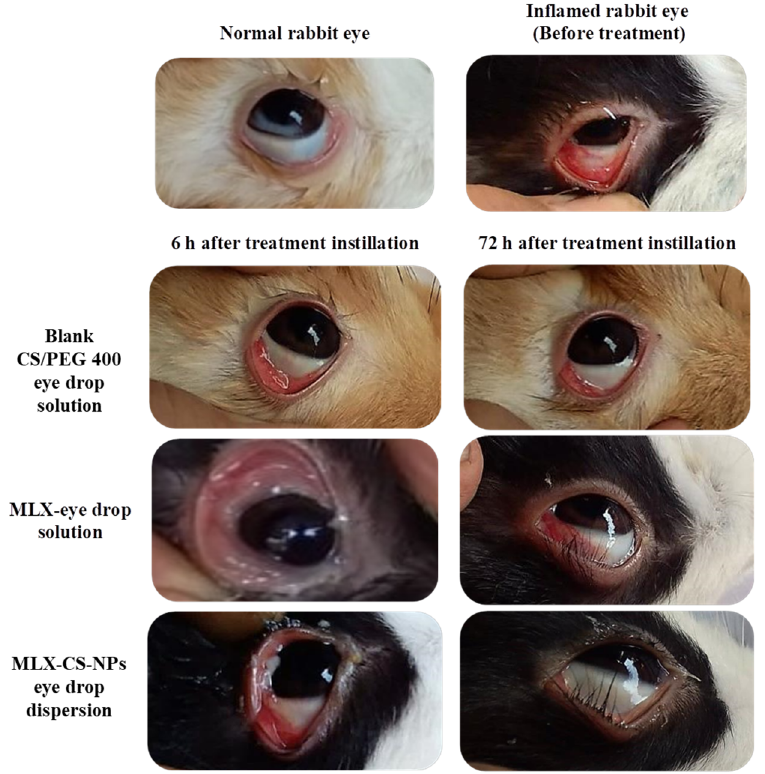
Table 9. Clinical examination scoring for the inflamed eyes after applying MLX-CS-NPs eye drop dispersion and MLX-eye drop solution.